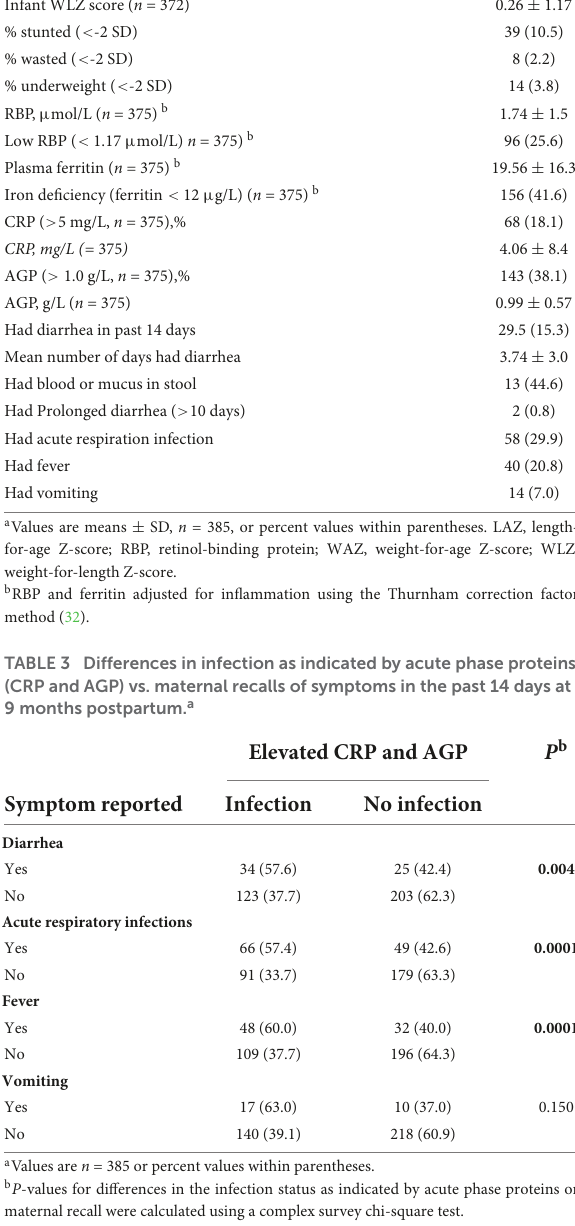
TABLE 2 Demographic, infection, and biochemical characteristics in a sample of 9-month-old Kenyan children. a Characteristics